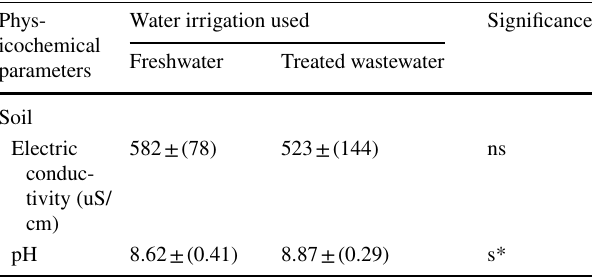
ns not significant, s significant, * p ≤